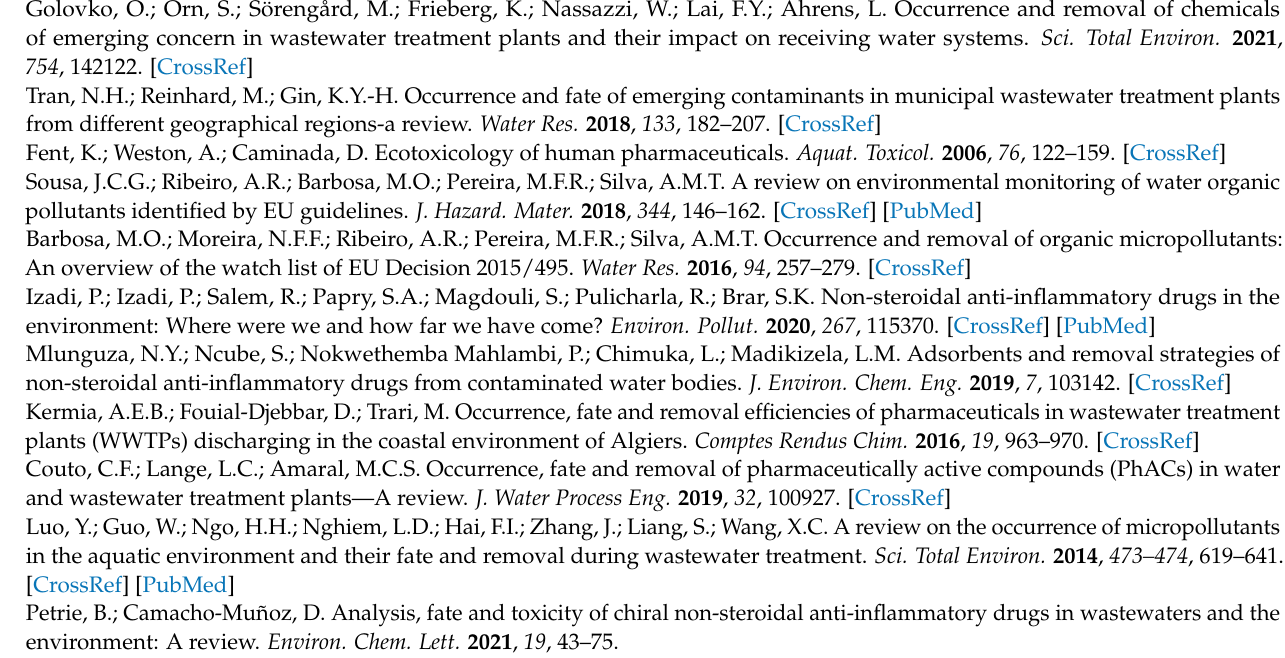
Table S2: 13 C CP/MAS, 29 Si MAS, and 29 Si CP/MAS NMR chemical shifts for TMC, SiO 2 /TMC/GPTMS, and SiO 2 particles and quantification of the 29 Si Q n resonances, Table S3: Equilibrium model parameters obtained from model fitting to experimental sorption data of Fe 3 O 4 @SiO 2 /TMC/GPTMS for the removal of DCF, NAP, and KET, together with the goodness of